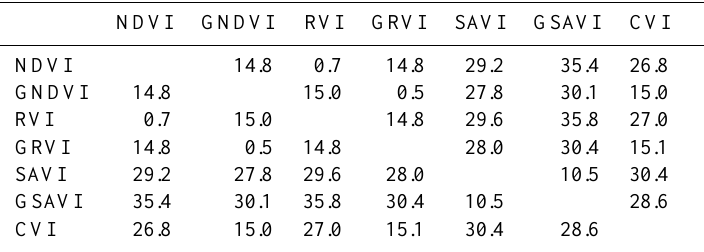
Table 3. Index of disagreement ID in percentage (%) of the total number of pixels where two VIs disagree on the direction of vegetation change, i.e. vegetation damage or